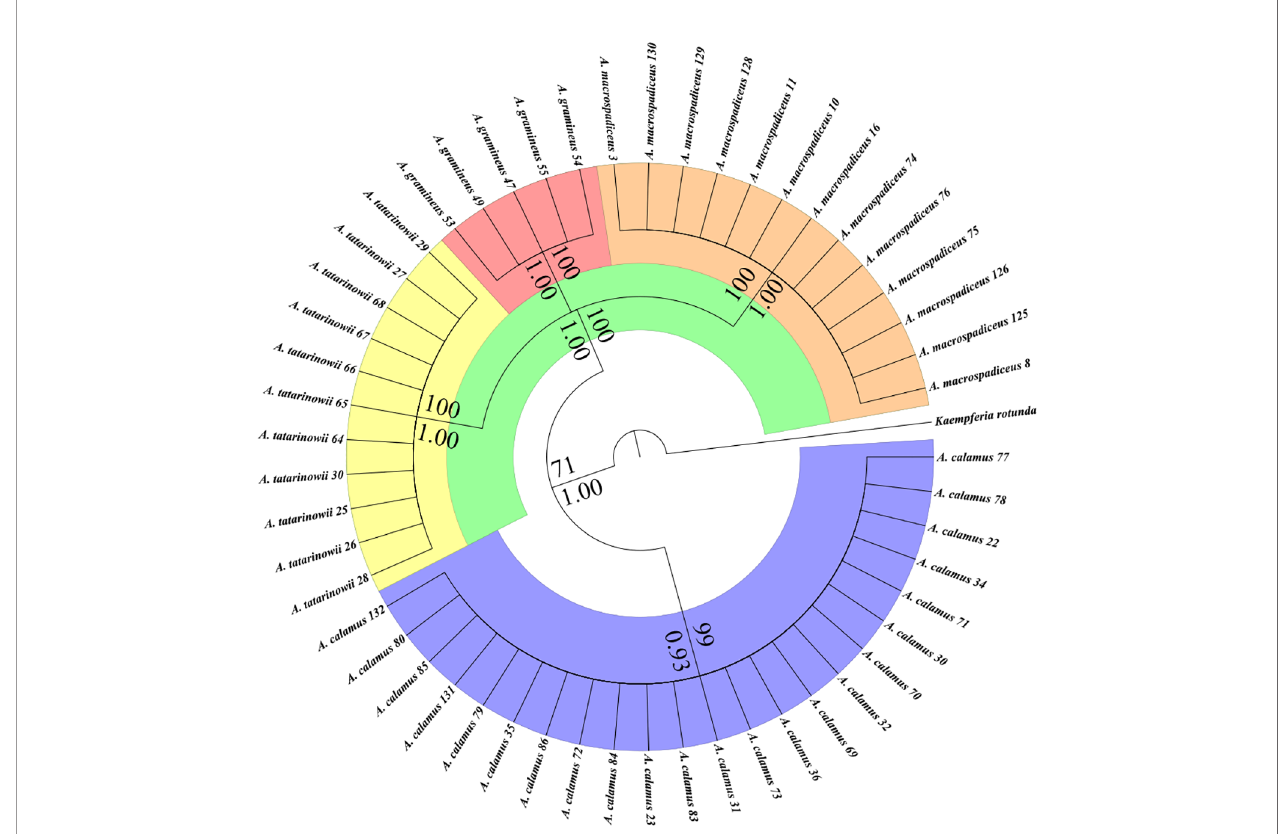
FIGURE 1 | Phylogeny of Acorus inferred with the maximum likelihood and Bayesian analyses based on two markers from chloroplast DNA. Bootstrap percentage (BP) ≥ 70 and Bayesian Posterior Probability (BPP) ≥ 0.90 are shown at branches. Four species gathered to different clusters and occupied independent branches. Blue, A. calamus . Red, A. gramineus . Orange, A. macrospadiceus . Yellow, A. tatarinowii